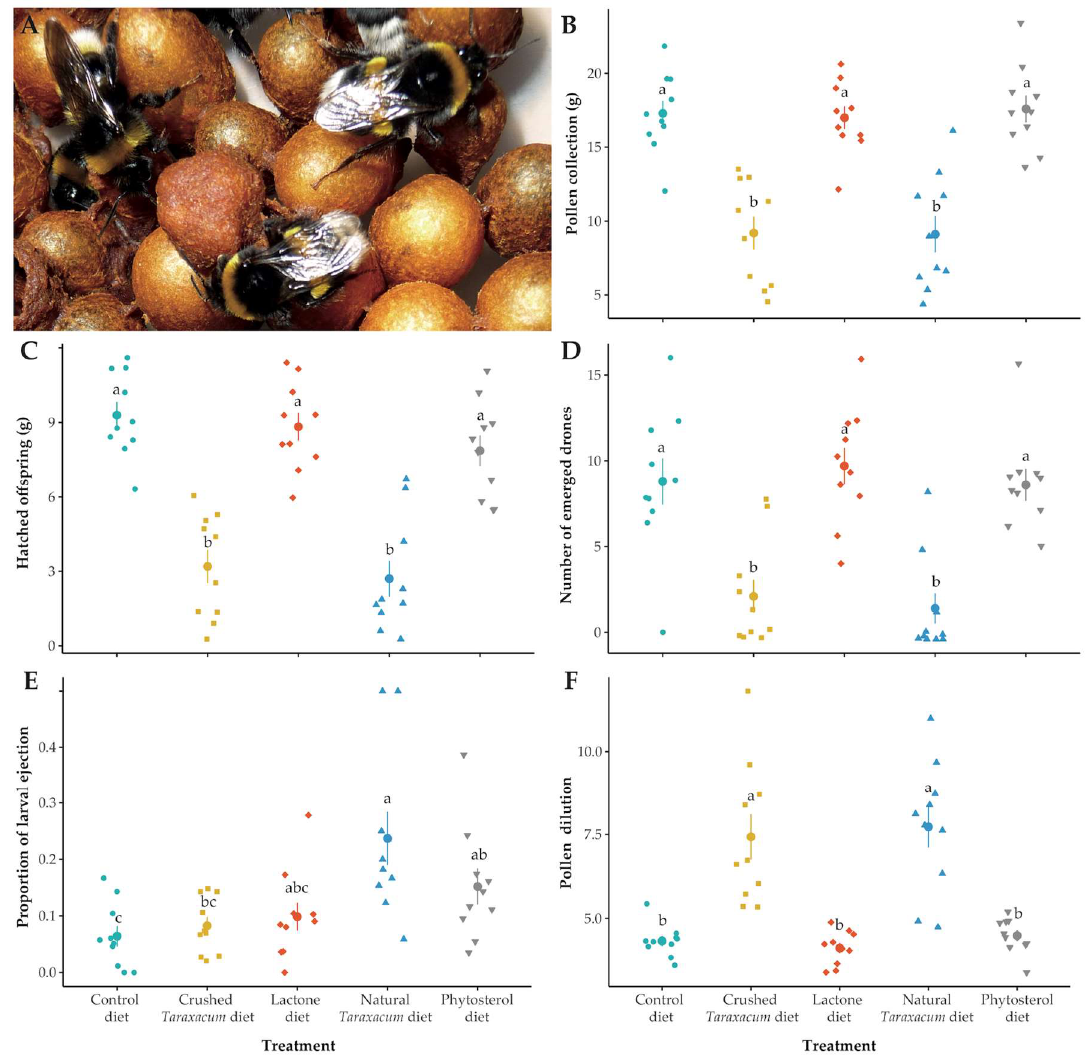
Figure 2. Effects of diet treatments on B. terrestris in micro-colonies. ( A ) Details of a micro-colony, photography N. Roger, ( B ) pollen collection in each micro-colony across treatments, ( C ) pollen dilution in each micro-colony across treatments, ( D ) total mass of hatched o ff spring in each micro-colony across treatments, ( E ) proportion of ejected larvae in each micro-colony across treatments, ( F ) number of emerged drones in each micro-colony across treatments. Each small data point represents a micro-colony and large points are mean values of each treatment. Error bars indicate the standard error of means. Letters indicate significance at p <